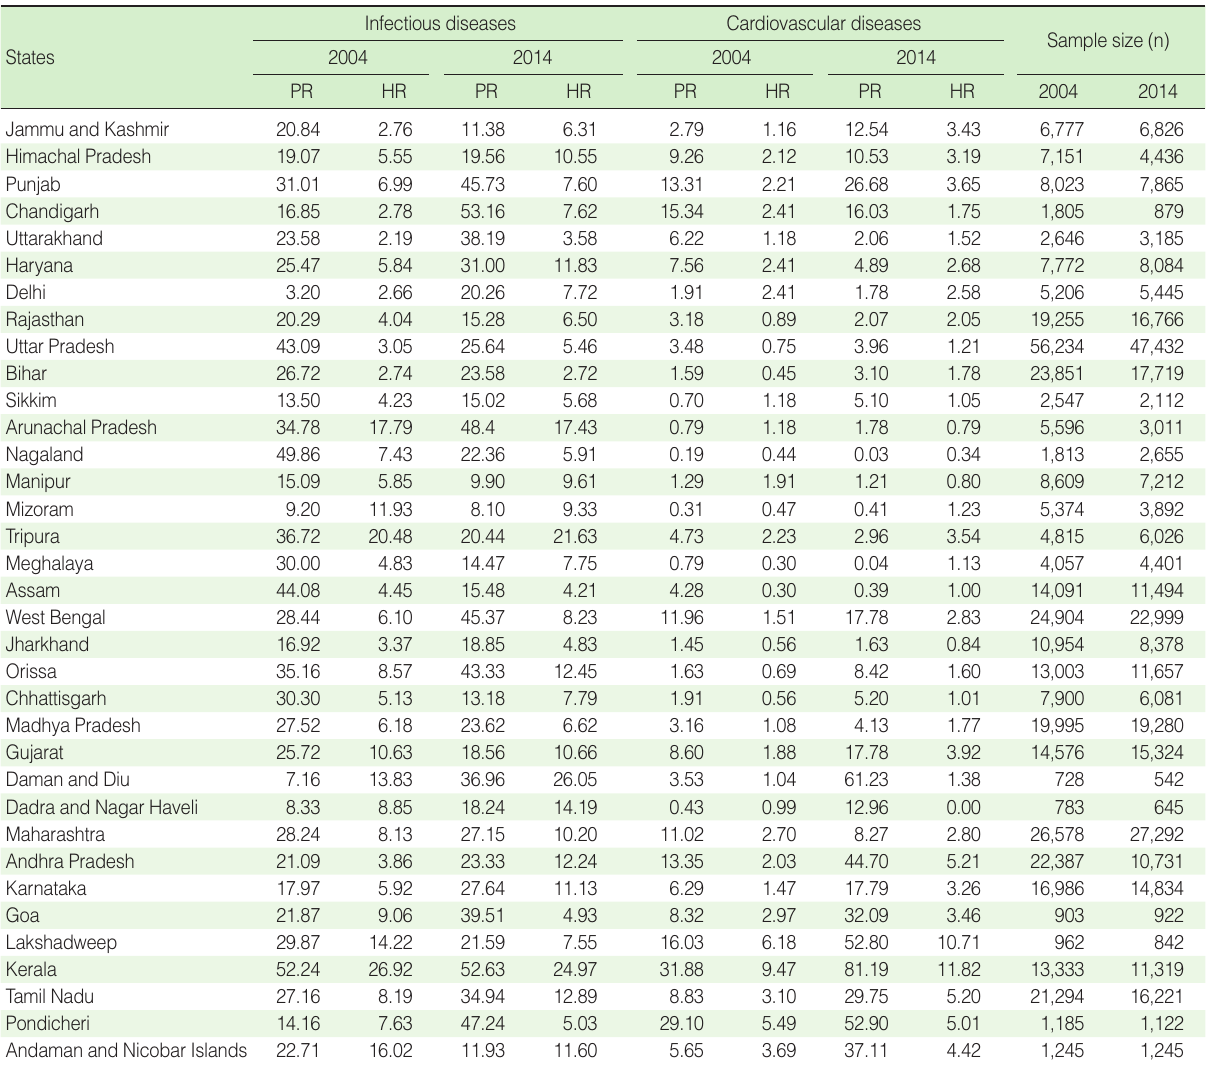
PR, prevalence rate; HR, hospitalization rate. Figure 1. Prevalence of infectious and cardiovascular diseases from 2004 to 2014 by age. Infectious Diseases Cardiovascular diseases Cardiovascular